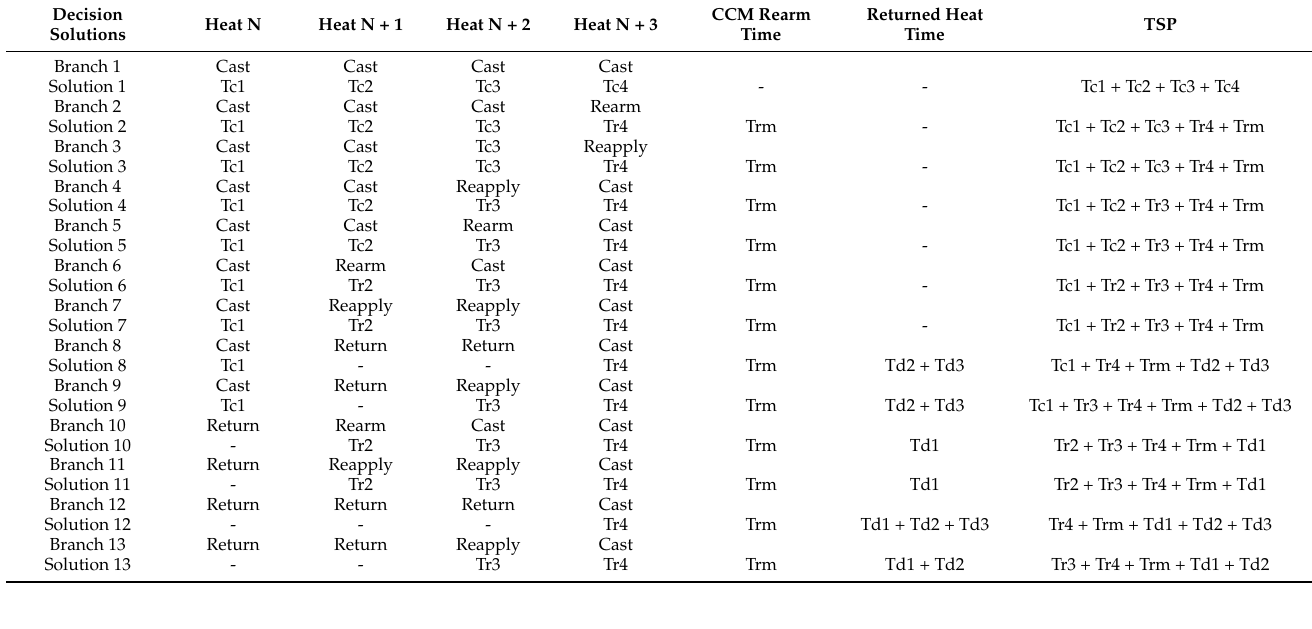
Table 2. TSP formulas for the branches of the decision tree.